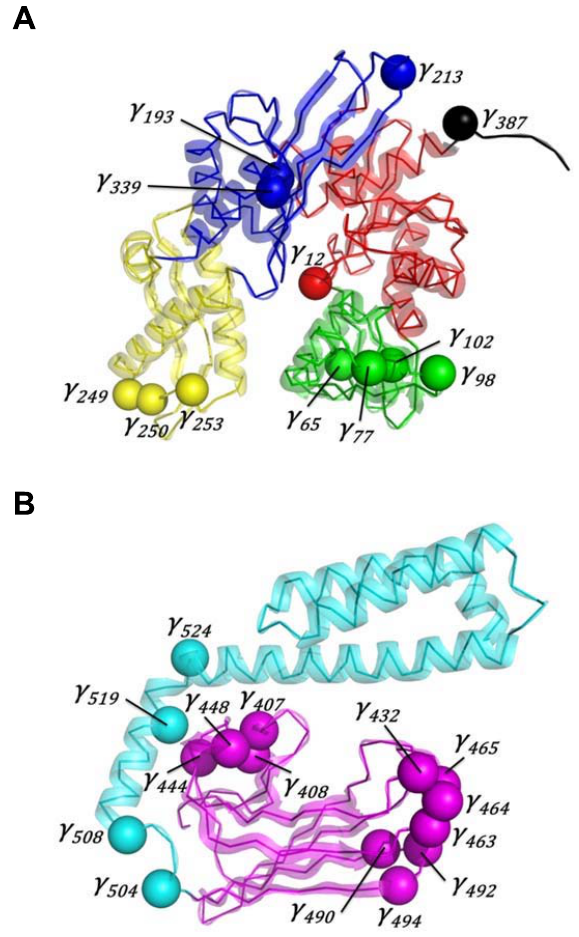
Figure 6. FEPs V( c ) for c 387 in k B T unit. V( c ) computed from APO, ADP-bound and ATP-bound MD simulations of DnaK are colored in red, blue and green respectively.